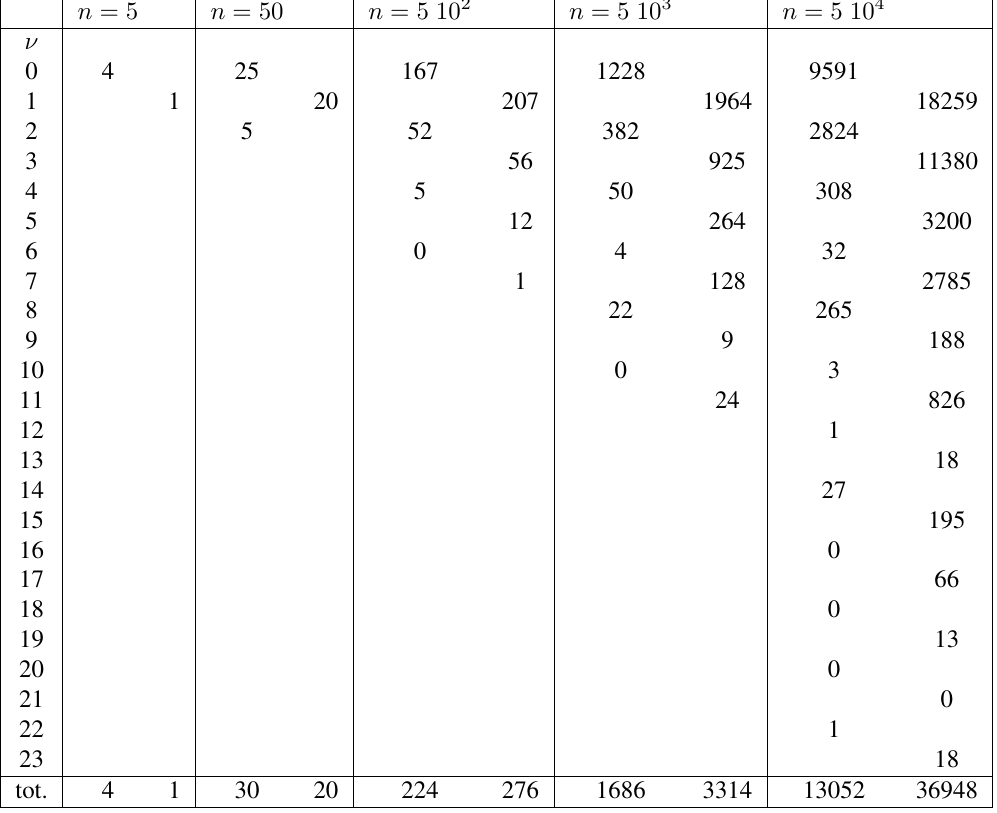
( ν ) of odd integers ≤ 2 n + 1 , with ν couples of divisors, Table 1: Distribution Π n for n = 5 , 50 , 5 10 2 , 5 10 3 , 5 10 4